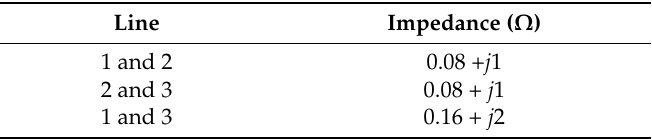
Table 4. Line data for Case